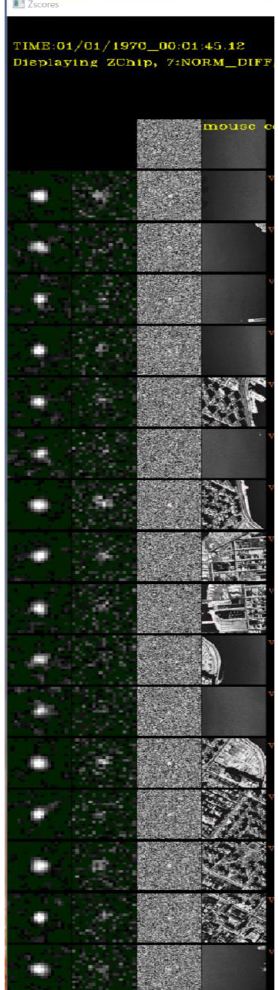
Figure 11. Comparison of Target Chips.